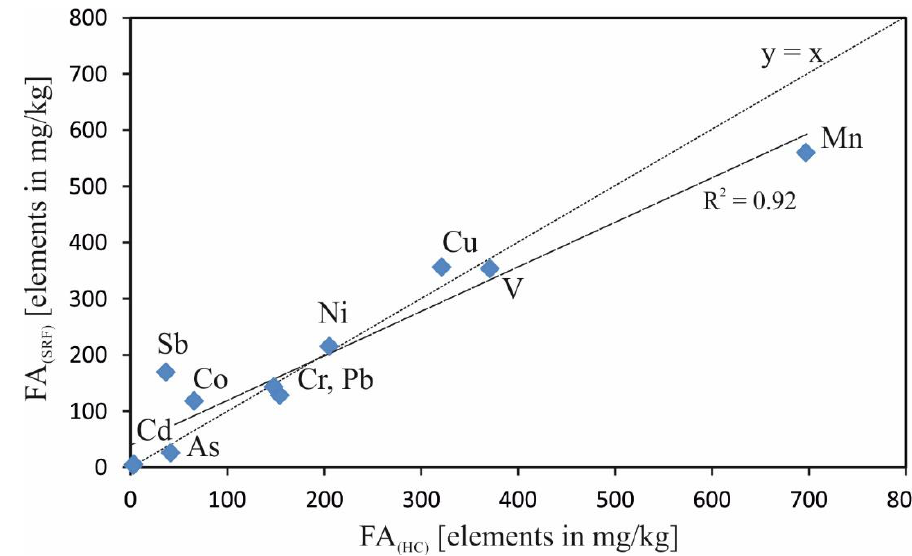
Figure 1. Correlation of trace elements in the studied fly ash samples.